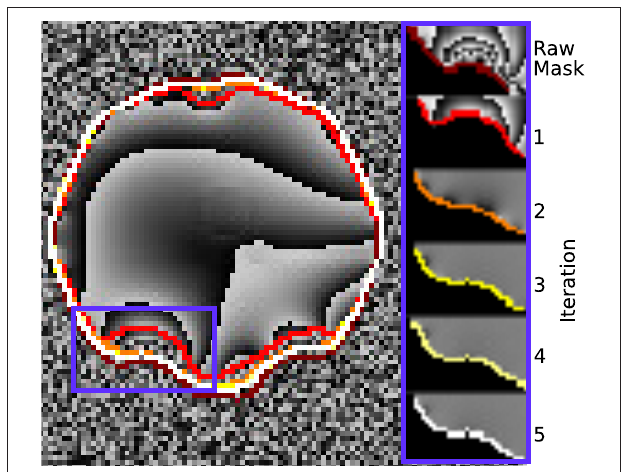
FIGURE 6 | Illustration of the evaluation mask for conventional (raw) processing and REFRASE analysis on the synthetic data (coronal slice). The purple frame indicates the masked region shown on the right-hand side. For REFRASE, a threshold of Q LC = 0.6 was chosen. Each coloured rim indicates the iteration step, shown in masked view on the right-hand side. The phase of the fourth echo is shown in the background.